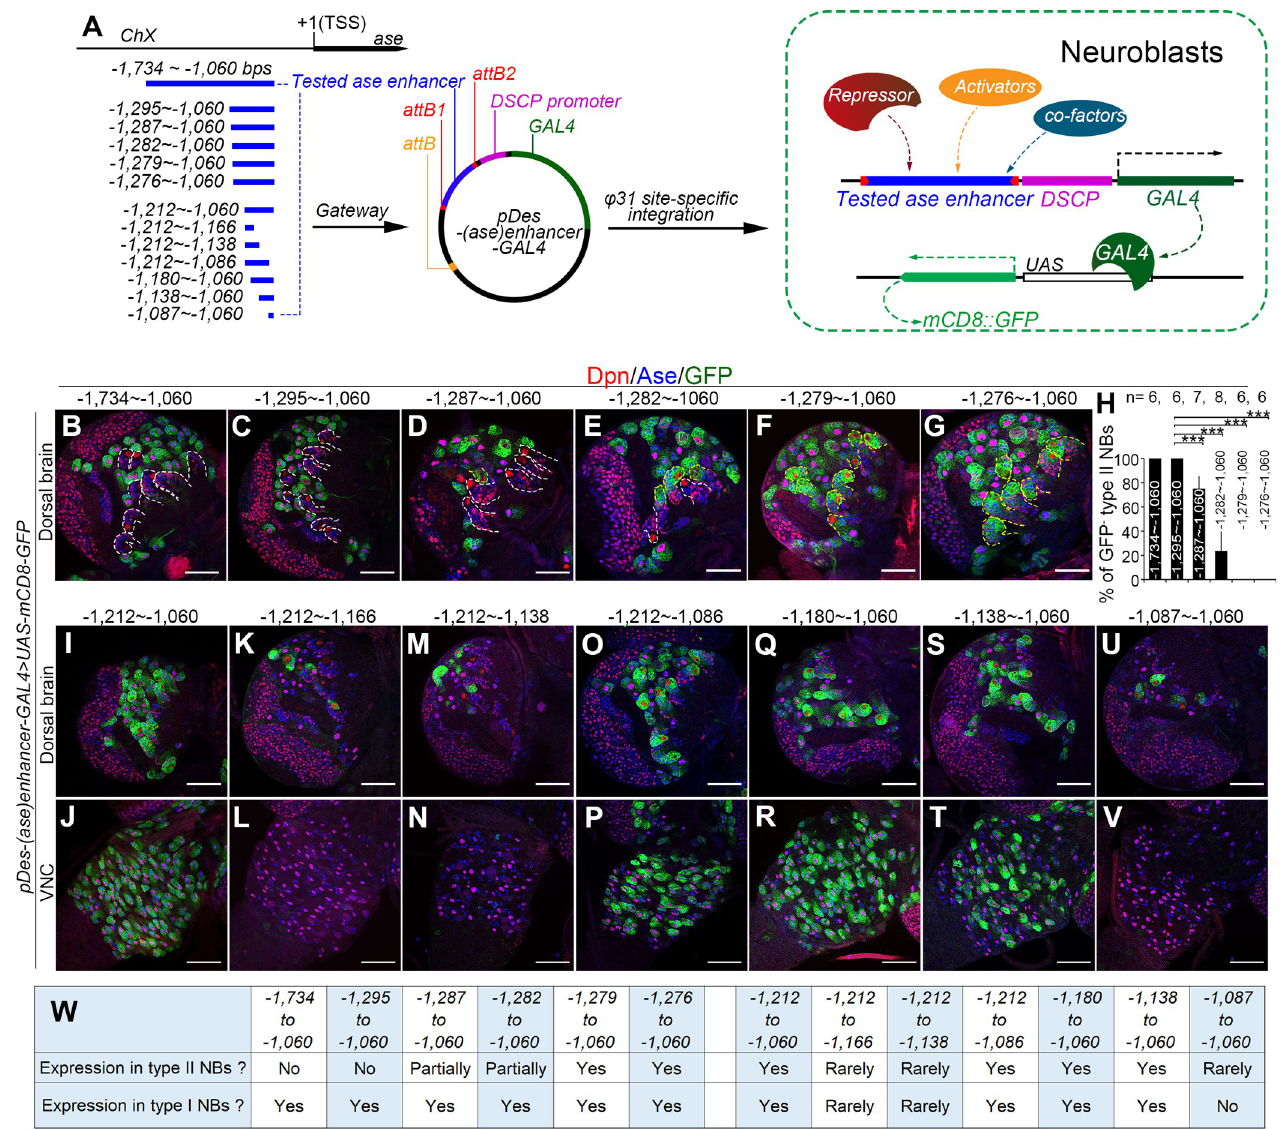
Fig 1. Identification of cis -elements mediating the repression and activation of Ase expression. (A) A diagram shows the tested ase enhancer fragments (in blue) and the strategy of the enhancer-activity-assay used to determine the activity of the fragments in type I NBs or in type II NBs. The ase enhancer fragments are amplified and cloned to upstream of Drosophila synthetic core promoter (DSCP)-GAL4 cassette in pBPGUW vector and the resulted pDes-(ase)enhancer- GAL4 constructs are integrated into Drosophila genome for determining their expression in type I and type II NBs by driving the expression of the UAS- mCD8-GFP reporter. (B-G, I-V) Expression of mCD8-GFP driven by the pDes-(ase)enhancer-GAL4 constructs with indicated ase enhancer fragments in type I NBs (Ase + Dpn + , appearing magenta in the nucleus) or type II NBs (Ase - Dpn + , appearing red in the nucleus) in the dorsal brains (B-G, I, K, M, O, Q, S, and U) or VNCs (J, L, N, P, R, T, and V). Images in (B-G) are for mapping the cis -elements mediating the suppression of ase in type II NBs and images in (I-V) are for mapping the cis -elements involved in activating ase in all NBs. Note that progressive deletion of the sequence from -1,295bp to 1,279bp leads to activation of mCD8-GFP in a subset of (D-E) or all type II NBs (F-G), whereas deletion of the sequence from -1,138bp to -1,086bp results in the loss of mCD8-GFP expression in all NBs in the VNC (L, N, and V) and in the majority of NBs in the brains (K, M, and U). Yellow dashed lines in (B-G) outline type II NB lineages with mCD8-GFP expression and white dashed lines in (B-G) outline the type II NB lineages without mCD8-GFP expression. In this and all the following figures, only images from one brain lobe or the thoracic segments of VNCs are shown. The brain lobes are oriented so that the midline is to the right and the anterior side of the brain up. Scale bars equal 50 μ m. (H) Quantifications of the percentage of type II NBs without mCD8-GFP expression in the brains with the GAL4 transgenes under the control of indicated ase enhancer fragments. Values of the bars are mean ± SD. ��� , P < 0.001. (W) Summary of the expression of mCD8-GFP driven by the pDes-(ase)enhancer-GAL4 constructs with indicated ase enhancer fragments in type I NBs or type II NBs.